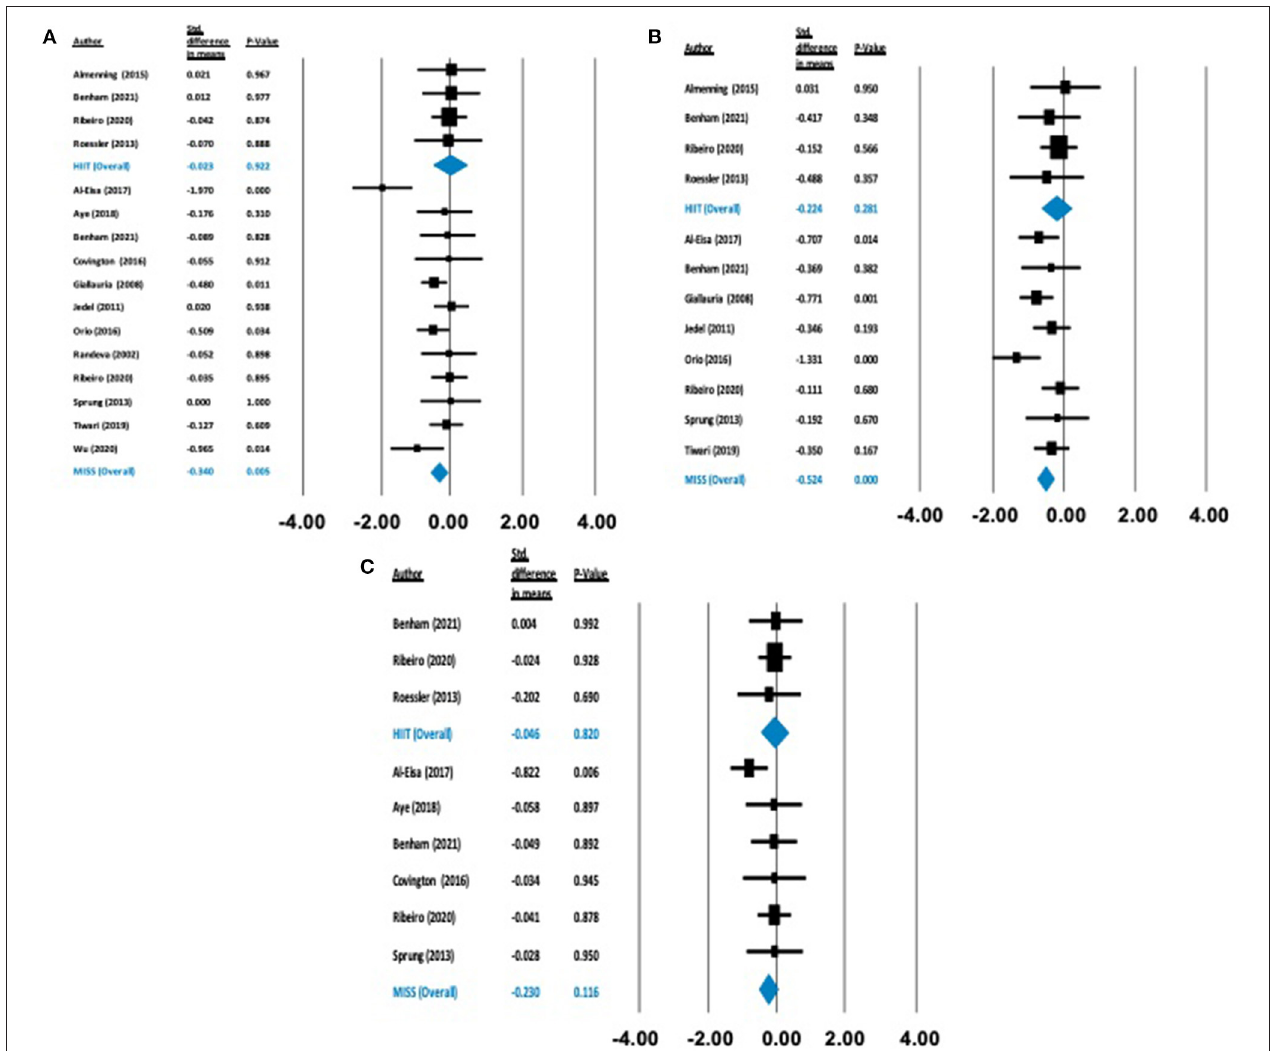
FIGURE 3 | Forest plots of standard difference in means 95% confidence intervals for: (A) BMI, (B) waist circumference, and (C) body mass as measures of ± anthropometric profile. Filled squares represent study outputs. Lines represent 95% confidence intervals. Filled blue diamonds represent the weighted mean determined through